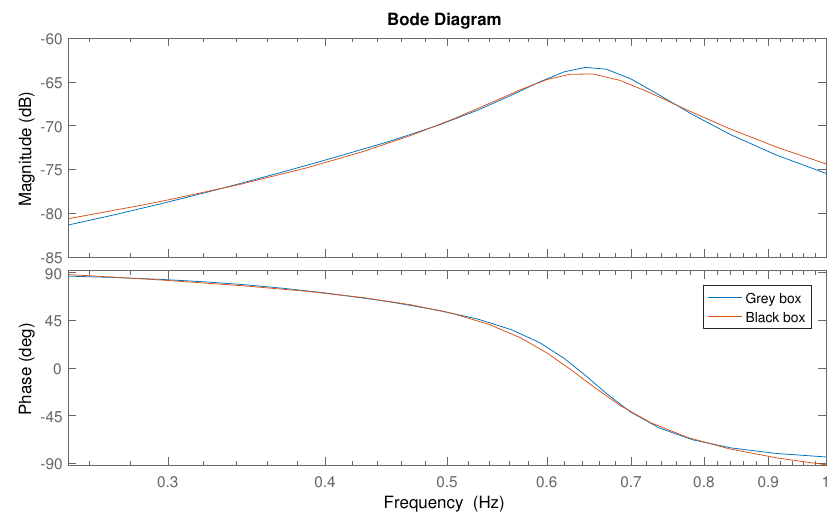
Figure 24. Comparison between the Bode plots of the Black box and the Grey box models. As an illustrative example, Figure 26 shows the time series of the output velocity calculated with both the Black box and Grey box models, compared to the measured velocity. Models have been identified using a pink spectra for the force (experiment 091), whereas the validation has been carried out using white multisine with a different amplitude (experiment 085). The friction term has been adjusted according to the approximation in (12). In this situation, the Black box model performed marginally better as it resulted in a 96% fitting compared to 94% of the Grey box model.